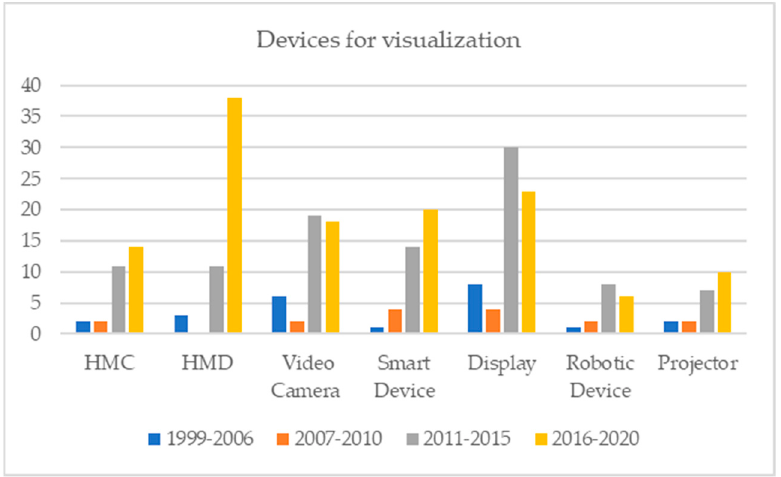
Figure 6. Number and type of devices for capturing and visualization between 1999 and 2020.